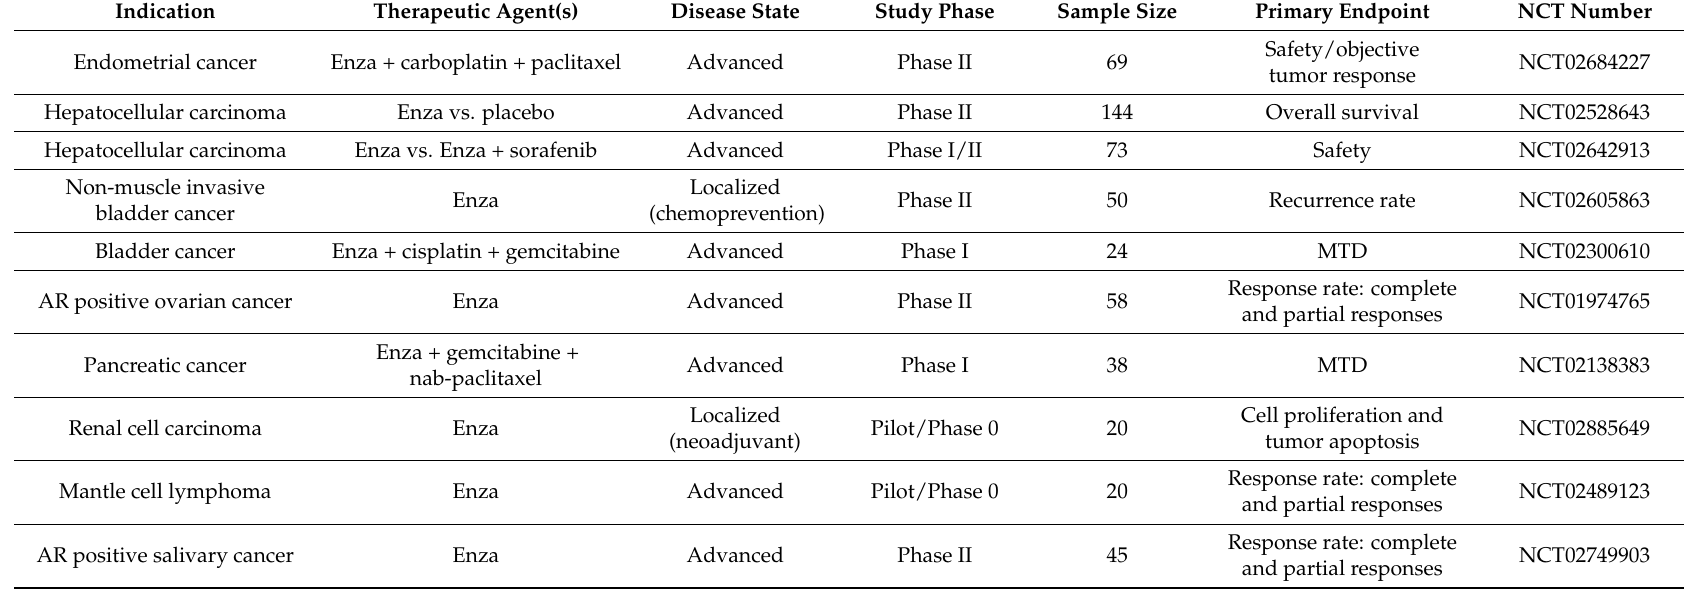
Table 2. Ongoing studies testing AR-directed therapies in cancers other than breast or prostate cancer. Enza, enzalutamide; AR, androgen receptor; and MTD, maximum tolerated